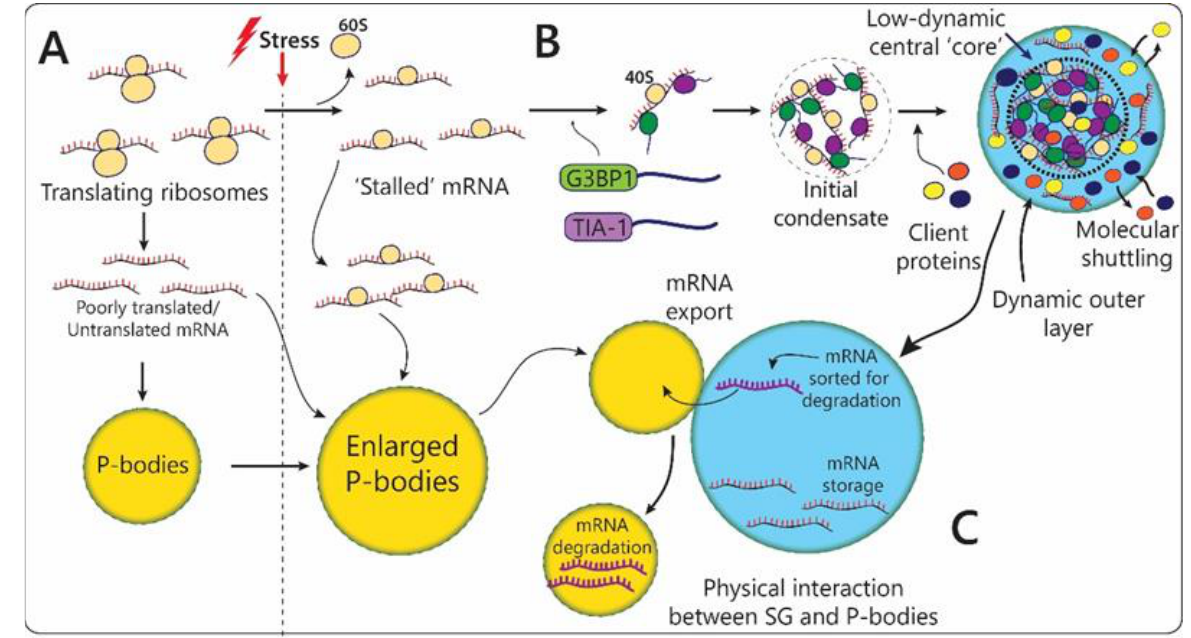
Figure 4. Stress granules and P-bodies interplay during stress response. ( A ) Under normal conditions, SGs are absent from the cytoplasm, mRNA translation is normal, and poorly translated or repressed mRNAs are sequestered into P-bodies. ( B ) Upon stress treatment, translation is inhibited and ‘stalled’ translation initiation complexes are recruited to P-bodies, causing their enlargement, or interact with SG proteins, such as G3BP1 and TIA-1. This interaction leads to phase separation and formation of initial pre-mature SG that then attracts more proteins. Mature SG has a low-dynamic central core and dynamic outer layer. ( C ) Stress conditions promote physical association between SG and P-bodies. It was suggested that within SG, the mRNA molecule undergoes sorting and the mRNA destined for decay are exported directly into P-bodies via temporal fusion between SG and P-bodies.